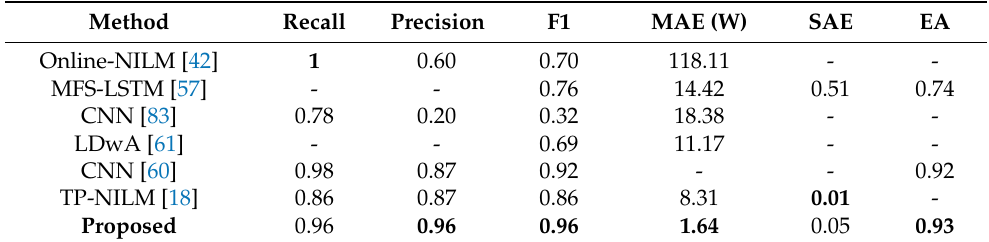
Table 8. Comparison results with existing non-intrusive load monitoring methods for washing